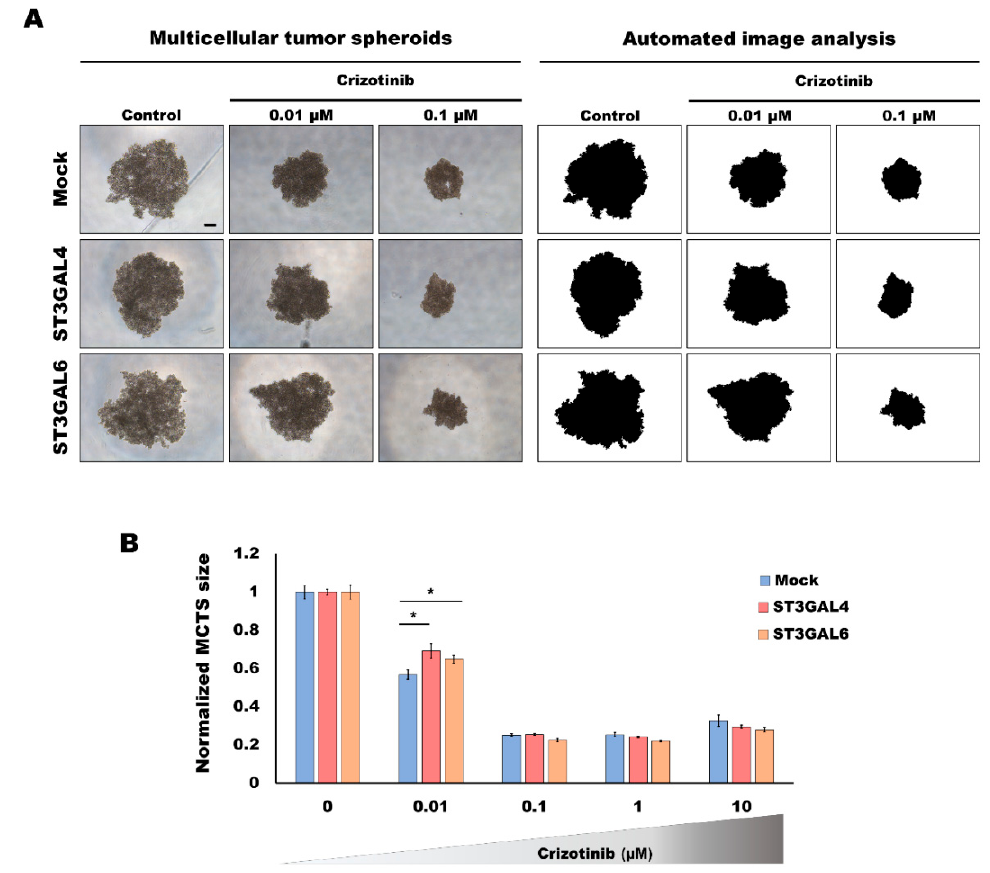
Figure 2. Analysis of the response to tyrosine kinase inhibitor (TKI) treatment of the α 2,3-overexpressing cancer cell models grown in 3D. Response to crizotinib treatment evaluated by automated image analysis of gastric multicellular tumor spheroids (MCTS) generated using ultra-low attachment (ULA) 96-well round-bottomed plates for 5 days and treated with di ff erent concentrations of crizotinib for 48 h. ( A ) Representative examples of the automated image analysis performed with the open-source Fiji software to determine the size of the gastric MCTS from images acquired with a Leica DMi1 microscope. Scale bar represents 200 µ m. ( B ) Graph represents the size variation in each spheroid after 48 h of treatment. Values are means ± SD of at least n = 3 spheroids. For each condition, 2 independent experiments were performed. Statistical significance was determined by student’s t -test ( p -value < 0.05 was considered significant, indicated as *).